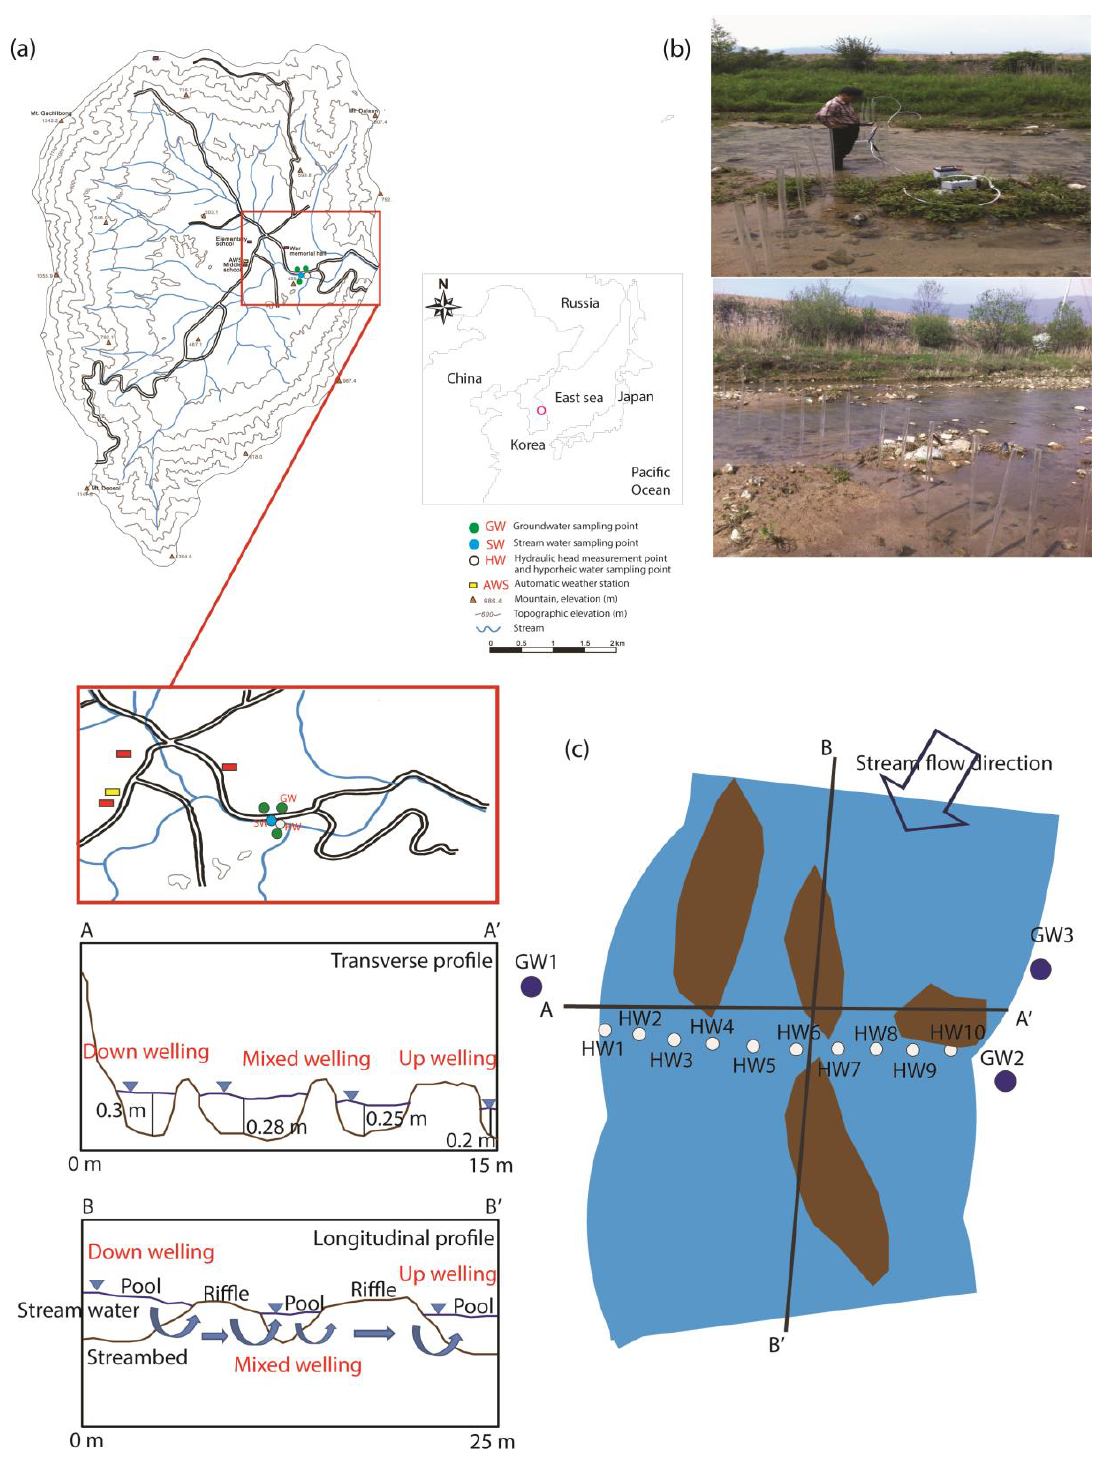
Figure 2. A map showing the sampling locations. ( a ) Location of study area and sampling points ( b ) Installed piezometers ( c ) Points of monitoring wells and piezometers